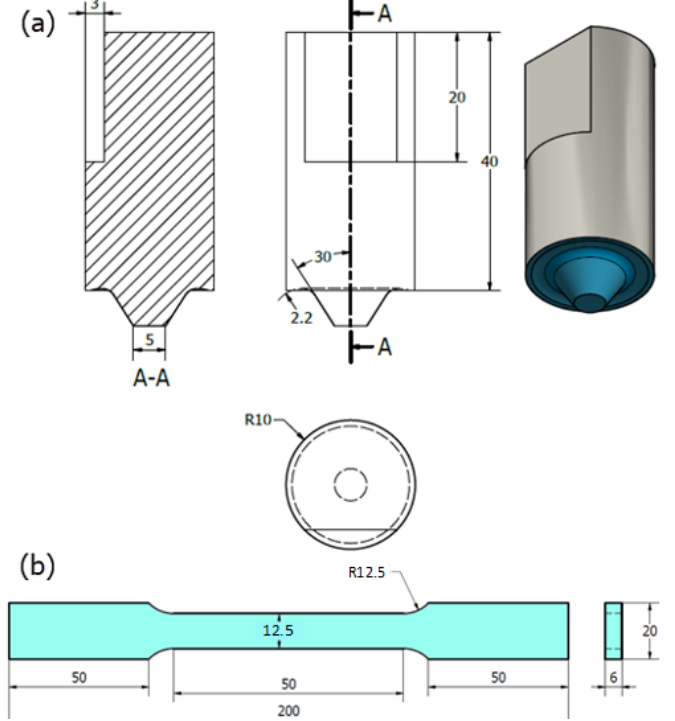
Figure 2. Schematic of ( a ) drawings of the WC FSW tool and ( b ) the tensile test sample (dimensions in